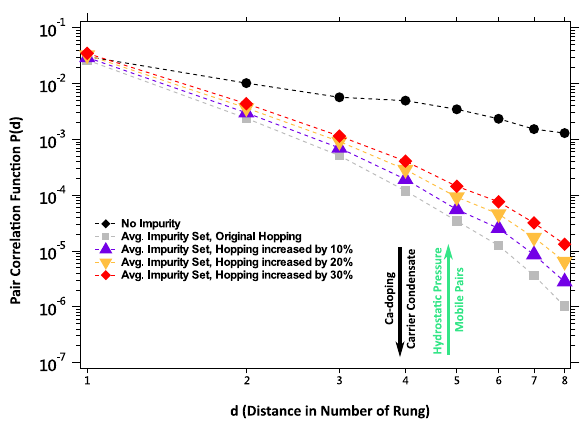
Fig. 5 Calculated pair correlations with Ca-doping and static pressure effects. Rung-singlet pair correlations plotted as a function of distance along the ladder-leg direction in logarithmic scale. For simplicity, the increasing hopping integral for simulating static pressure is uniform over the ladder cluster. The Hubbard repulsion and impurity potential V imp are kept fi xed in these